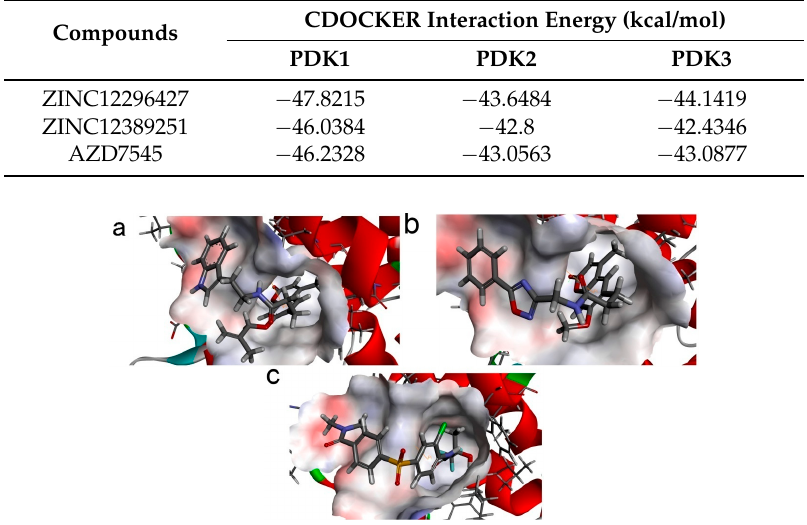
Figure 1. The structures of the novel compounds from virtual screening and the reference AZD7545.